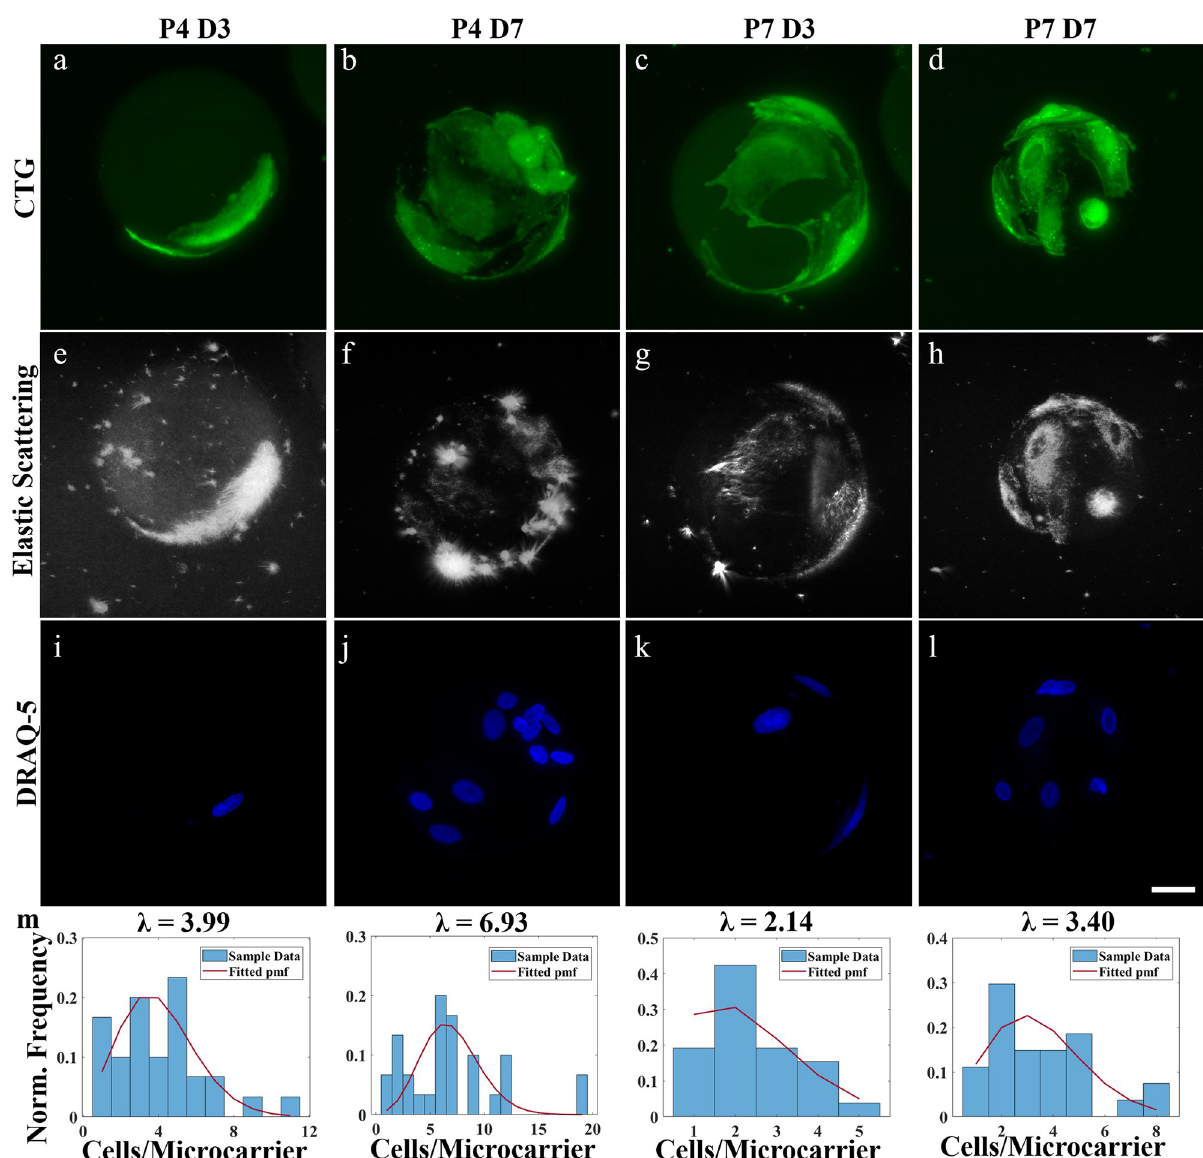
Fig 1. LSM and hydrogel microcarriers enable direct cell enumeration (DRAQ-5) and volume (CTG) quantification in toto . Representative 2D LSM max. intensity projections of ih-MSCs attached to gelMA microcarriers at passage 4 day 3 (P4 D3), passage 4 day 7 (P4 D7), passage 7 day 3 (P7 D3), and passage 7 day 7 (P7 D7) using a-d) CTG fluorescence and e-h) elastic scattering contrast. i-l) DRAQ-5 labeled nuclei were used to estimate the m) normalized frequency of counted ih-MSCs attached to single gelMA microcarriers at P4 D3 (n = 30), P4 D7 (n = 20), P7 D3 (n = 23), and P7 D7 (n = 26). A zero-truncated Poisson distribution is fit over the sampled data (red line). Scale bar = 25 μ m.